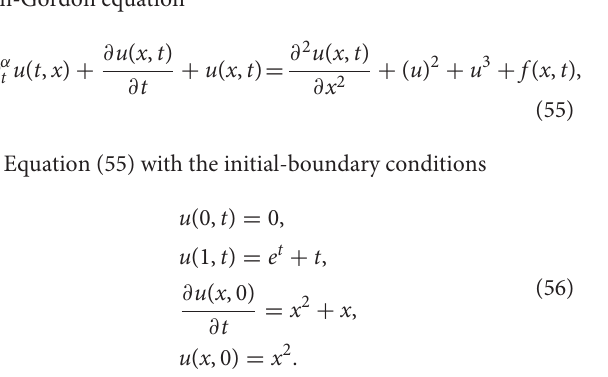
Table 3 . Our results clearly shown the complete agreement of obtained results.